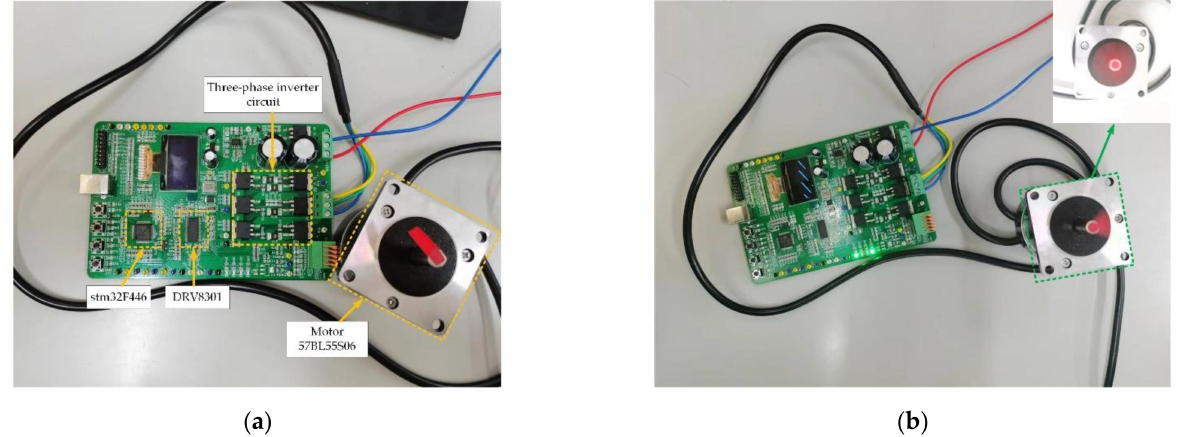
Figure 8. PMSM experiment platform. ( a ) the motor is in a state of stop. ( b ) the motor is in a state of rotation.